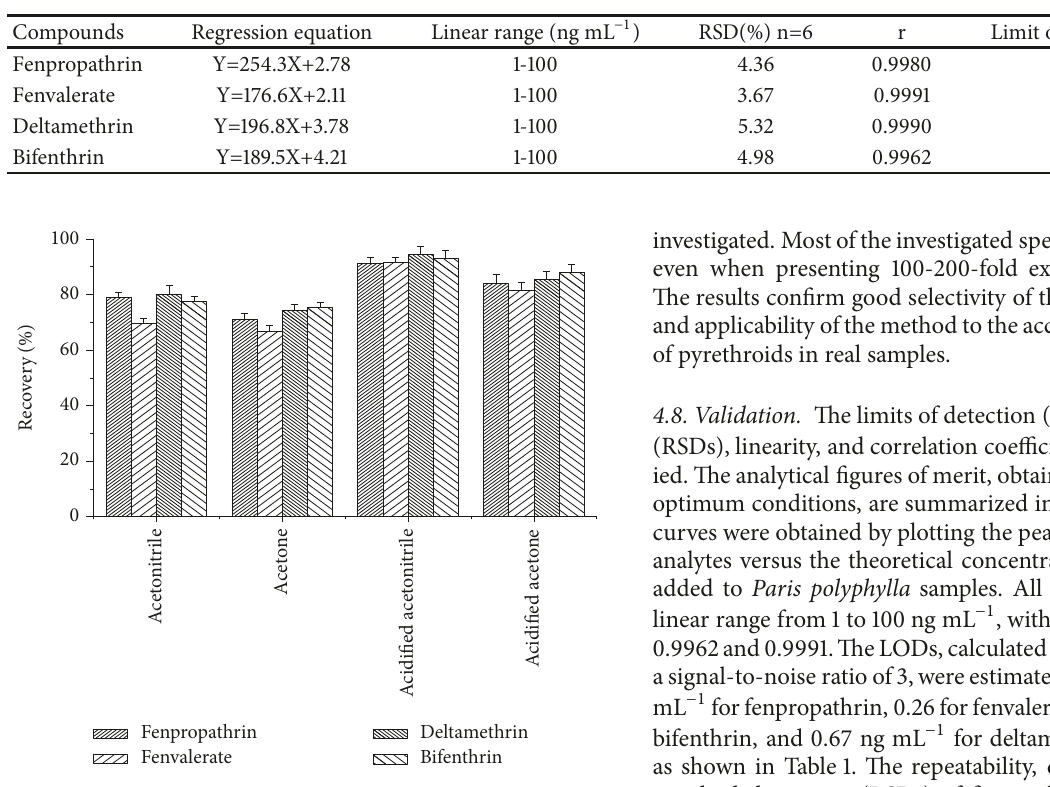
Table 1: Analytical features of the proposed method.